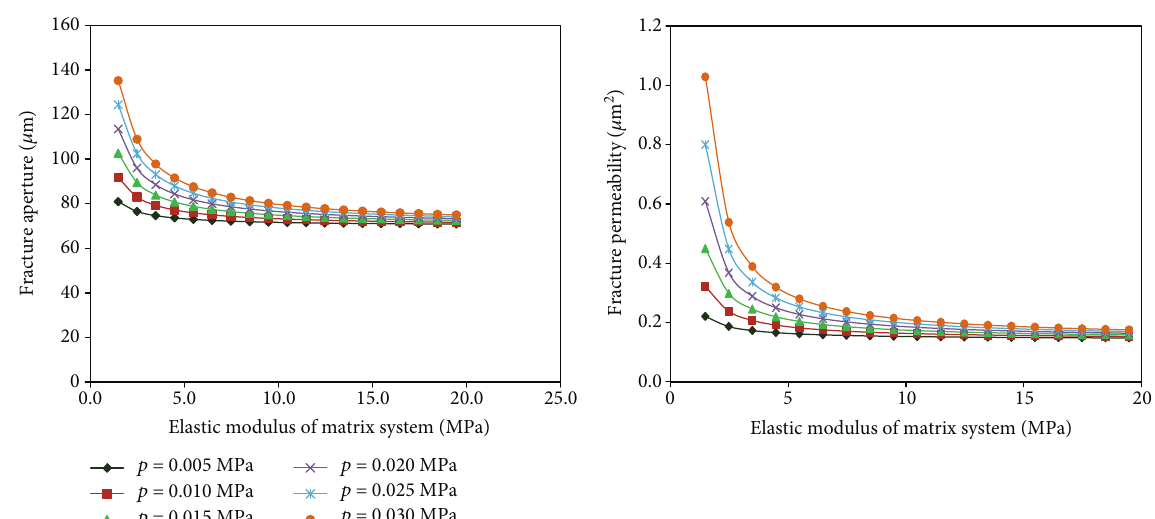
Figure 15: Fracture aperture and fracture permeability vs. fracture modulus.